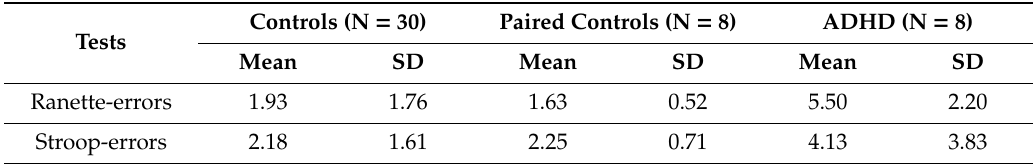
Table 1. BIA Scores in a) typical children from the Crepaldi et al. (under review) study, b) the paired control group, and c) the clinical group of ADHD children from the study reported in this